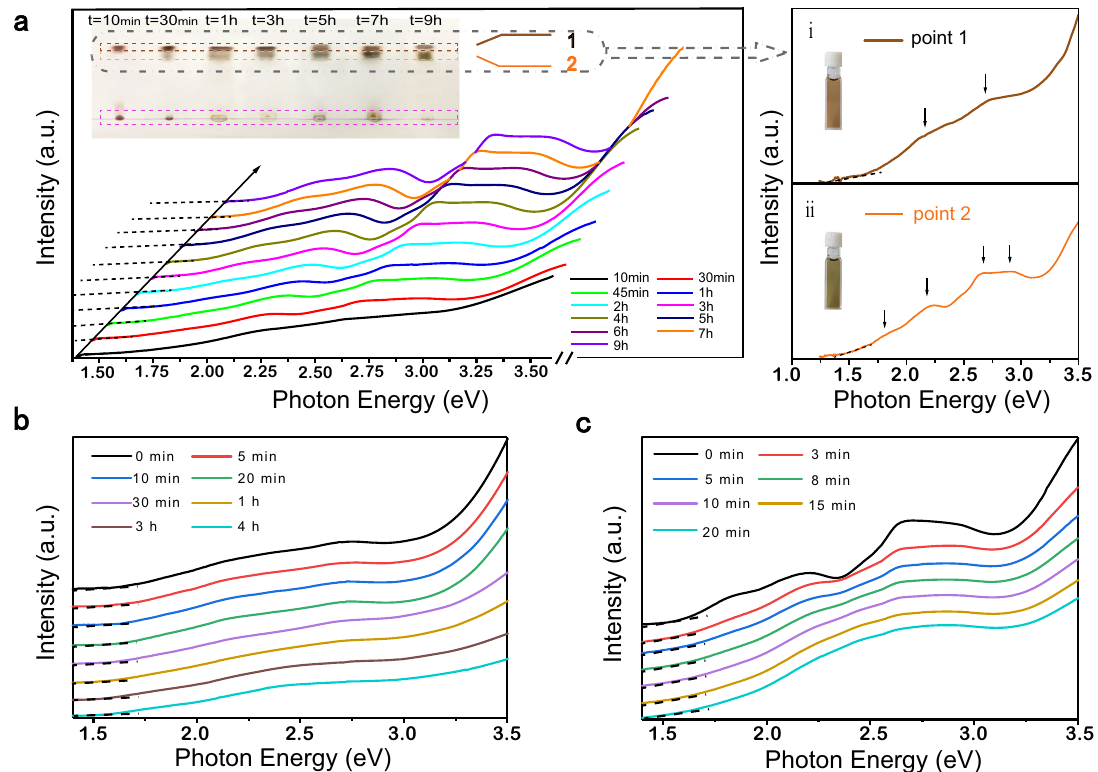
Fig. 3 Dynamic growth process of the bi-nanocluster. a Time-dependent UV – Vis spectra of the reaction process from 10 min to 9 h plotted on the photon energy scale. The UV – Vis spectra of thin-layer chromatography component points dissolved in dichloromethane (ai) “ point 1 ” , (aii) “ point 2 ” . Insert plots: thin-layer chromatography indicates the separation of reactants at different time interval;digital photos of the dichloromethane solution of separate components. Time-dependent UV – Vis spectra showed the disappearance of totally structured features of the b “ point 1 ” , c “ point 2 ” at room temperature. “ Points 1 and 2 ” represent AuAg 24 and Au 2 Ag 41 , respectively.